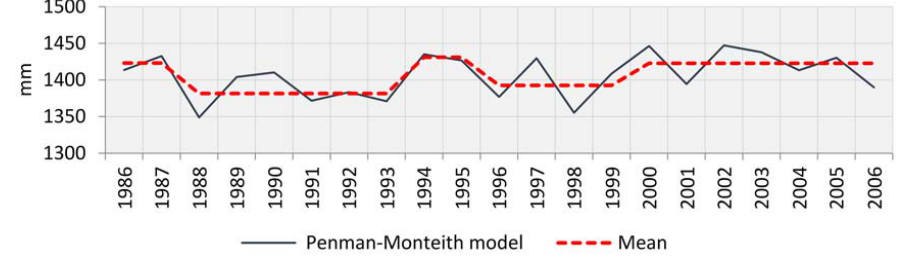
Figure 7. Regime shifts in potential evaporation as computed by the Penman-Monteith model.